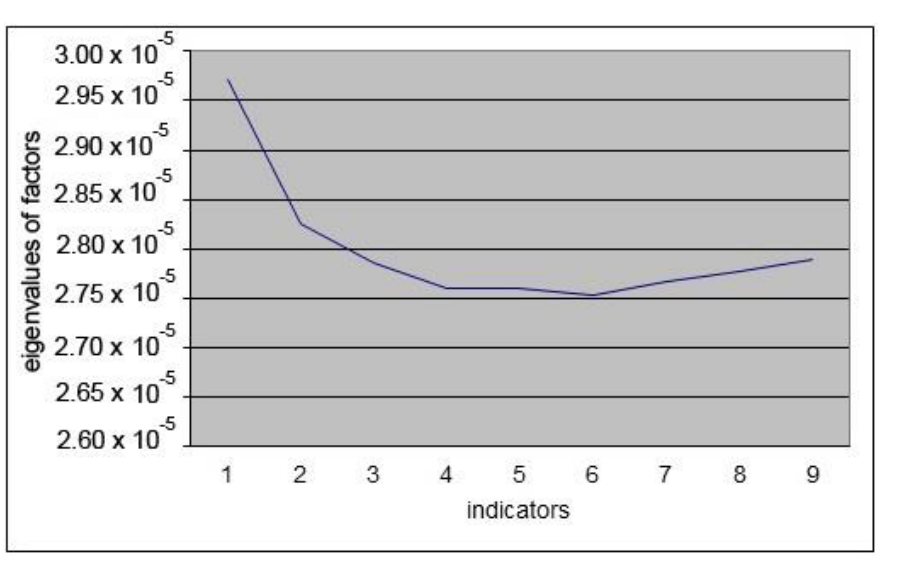
Figure 5. Malinowsky error analysis indicating 4 and 6 factor solution.